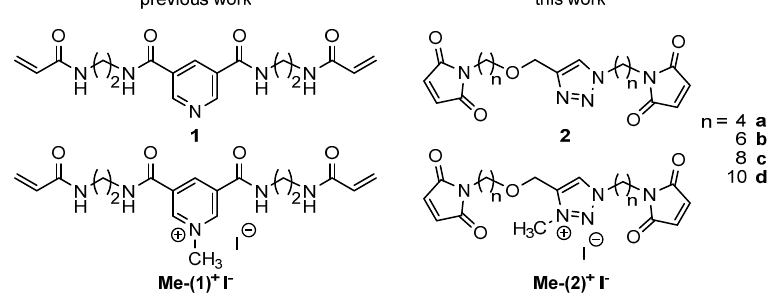
Figure 1. Low-molecular-weight cross-linkers with pyridine or triazole cores.